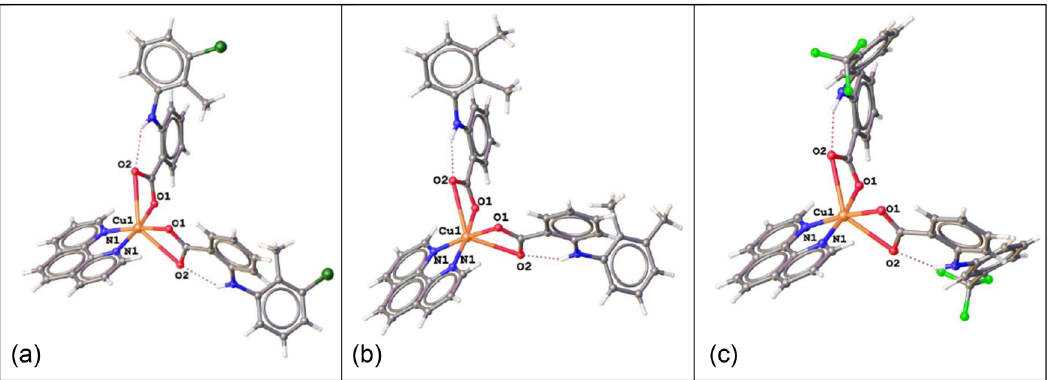
Figure 2: Molecular structures of the Cu ( II ) complexes. ( a ) Molecular structure of complex [ Cu ( tolf - O,O ′ ) 2 ( phen )] ( 1 ) . ( b ) Molecular structure of complex [ Cu ( mef - O,O ′ ) 2 ( phen )] ( 2 ) . ( c ) Molecular structure of complex [ Cu ( fl uf - O,O ′ ) 2 ( phen )] ( 3 )